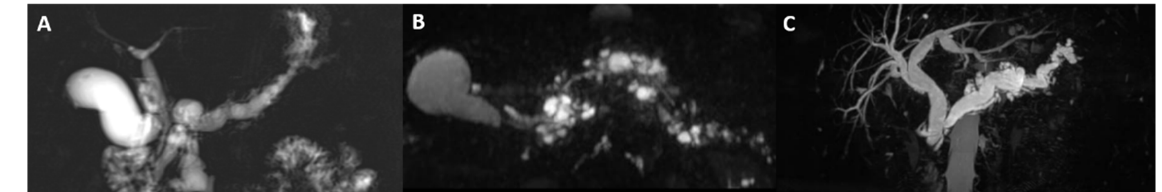
Figure 1. Magnetic resonance cholangiopancreatography (MRCP) showing: ( A ) Main duct Intraductal papillary mucinous neoplasm (IPMN), ( B ) Multifocal side-branch IPMN, ( C ) Mixed-Type